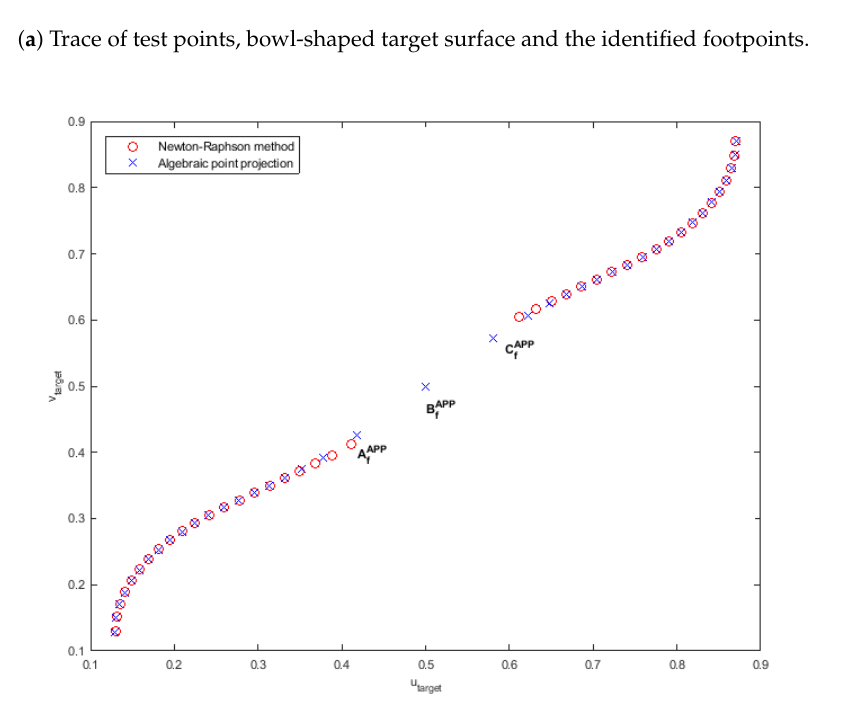
Figure 19. Illustration of the robustness of the 3D algebraic point projection algorithm involving discontinuous footpoints. ( a ) Trace of points that were projected onto bowl-shaped target surface using the proposed algebraic method and the Netwon-Raphson method. ( b ) Parameters of footpoints on the target obtained by both the methods. Discontinuity occurs due to non-unique footpoints for test points near the bottom of the